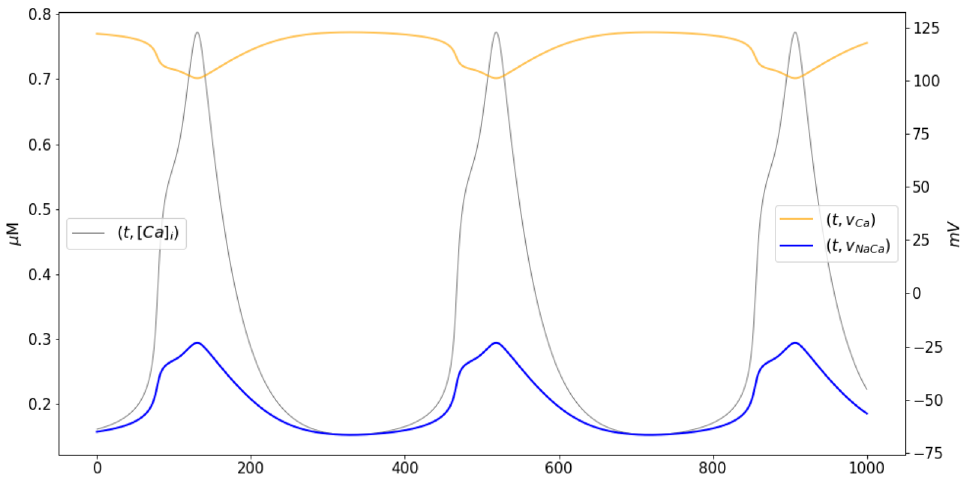
Figure 6. Calcium dynamics during pacemaking. Time courses of the intracellular calcium concentration (gray, left axis), the Nernst potential for Ca 2+ (orange, right axis), and the reversal potential for the Na-Ca exchanger (blue, right axis). Notice the two phases of calcium increase that occur in agreement with the double peak observed in the calcium current (see Figure 4B, blue